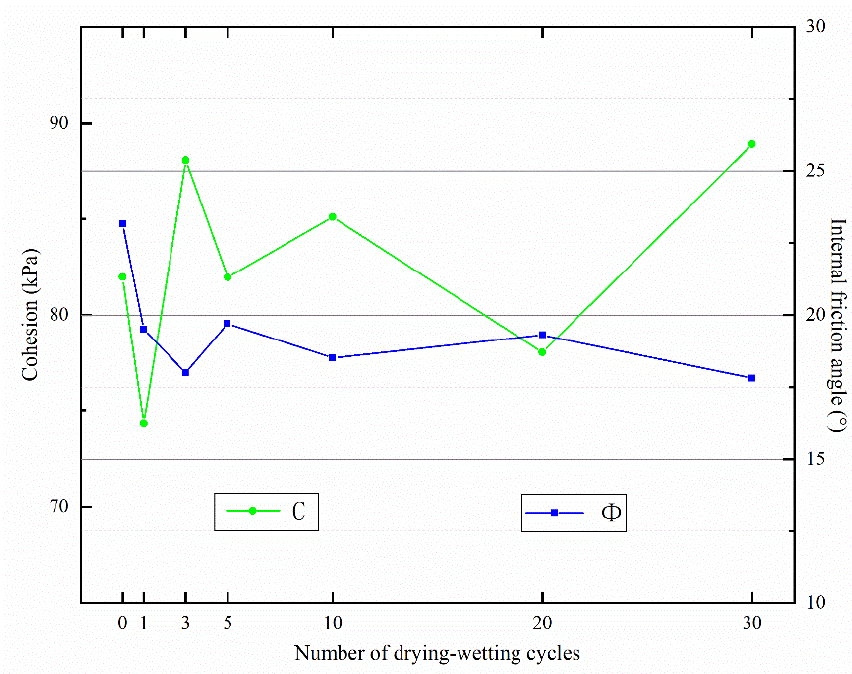
Figure 7. Variation of shear strength parameters with the number of drying–wetting cycles.